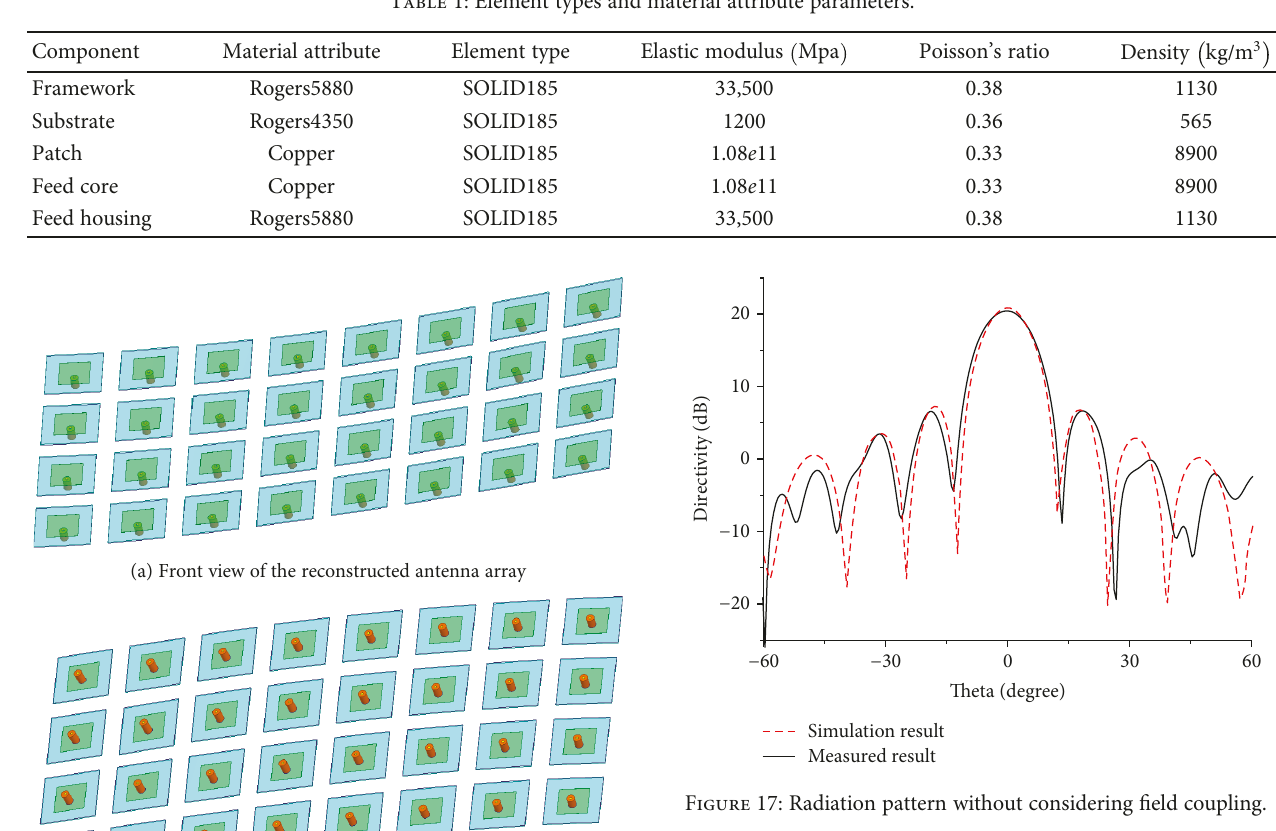
Table 1: Element types and material attribute parameters.